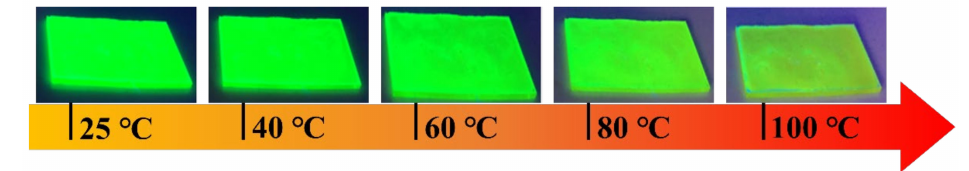
Figure 9. Photographic images of CsPbBr 3 MC thin films under UV light with thermal annealing.